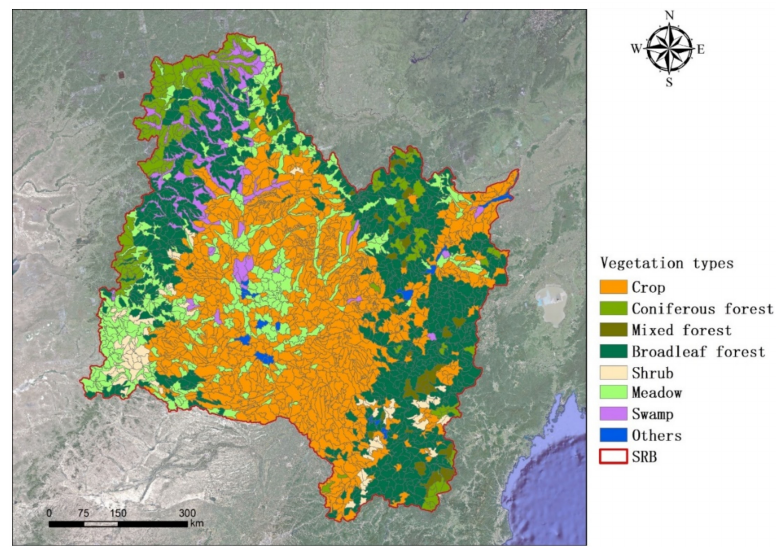
Figure 8. Distribution map of vegetation types.